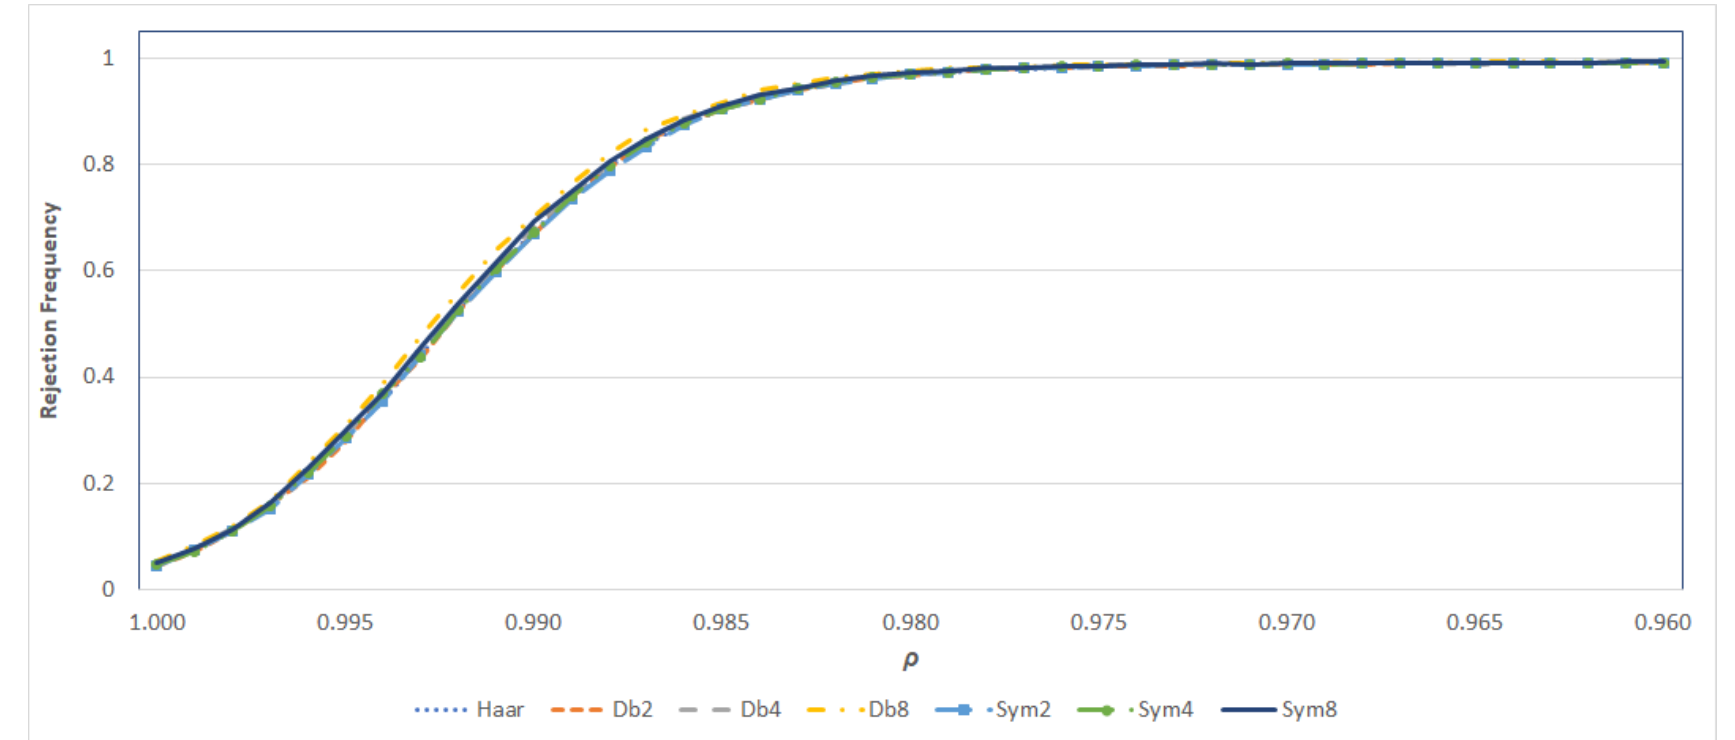
Figure 2. Asymptotic power curves of the wavelet based MZ α with different wavelet filters under GLS demeaning. Note: Filters are defined in the